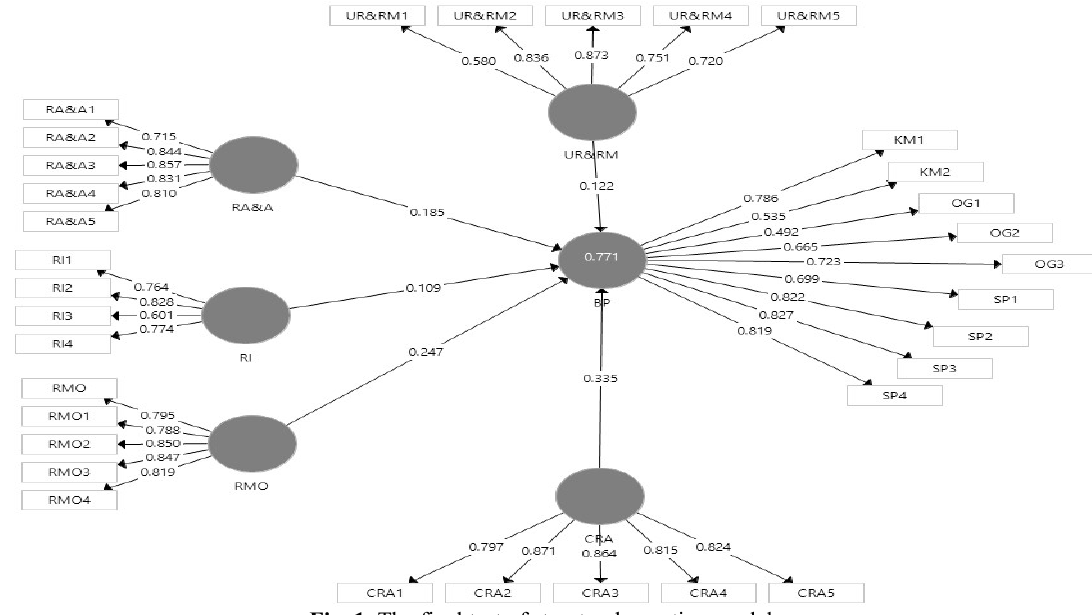
Fig. 1. The final test of structural equation model